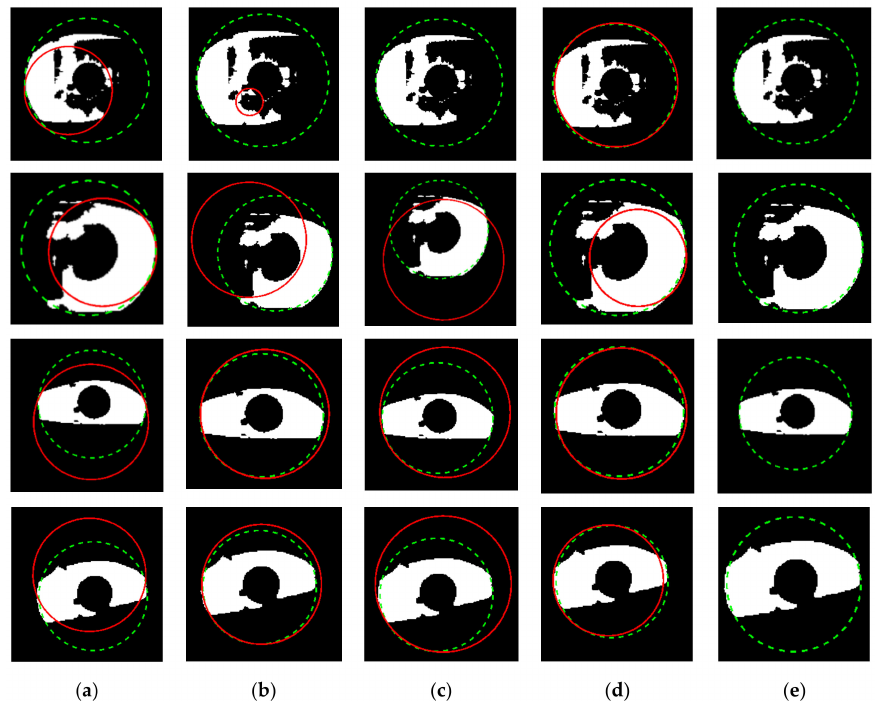
Figure 17. Failure cases on challenging images compare with other works to recover the outer boundary. ( a ) Proposed method; ( b ) Li et al. [4]; ( c ) Li and Huang [8]; ( d ) Ronneberger et al. [37]; ( e ) Duda and Hart [46]. The dashed line denotes the ground-truth, the red line denotes the prediction of the outer boundary.